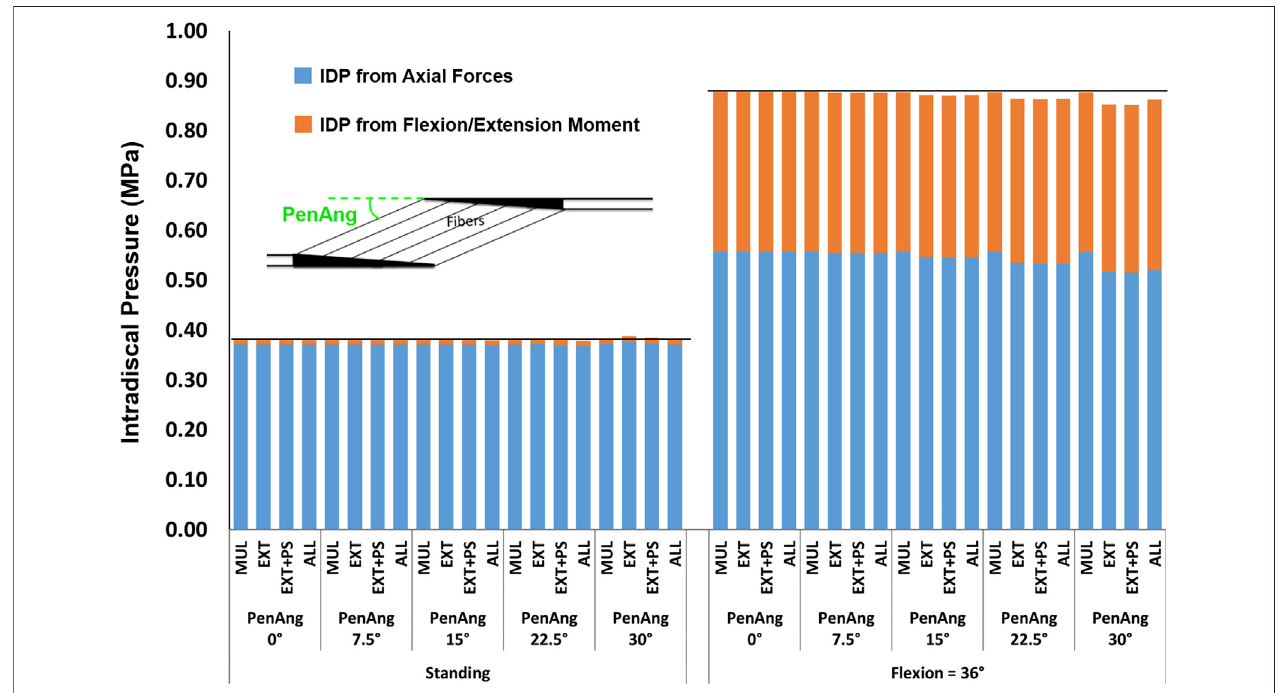
FIGURE 11 | The effect of different pennation angles on L4-L5 IDP in upright standing and 36 ° fl exion for four scenarios: changes applied to multi fi dus (MUL), extensor muscles (EXT), extensor muscles, and psoas (EXT + PS), and all 210 muscles in the model (ALL). The black horizontal lines represent the baseline values.